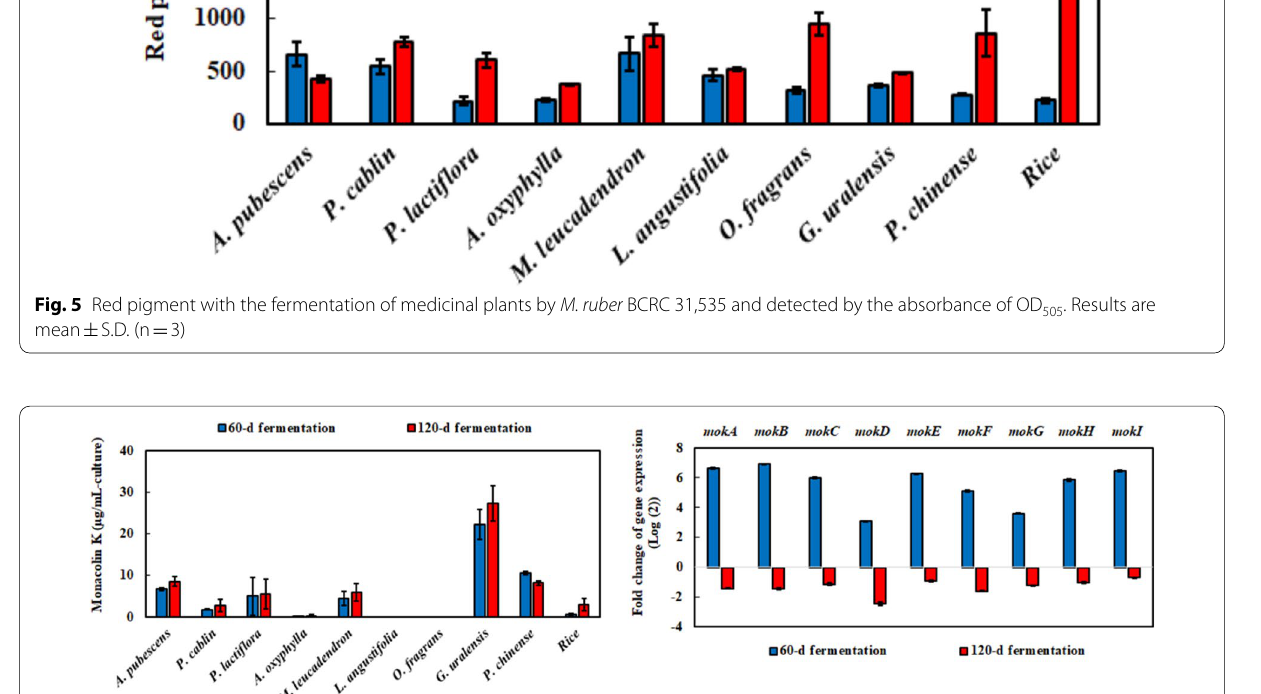
Fig. 6 Monacolin K with the fermentation of medicinal plants by M. ruber BCRC 31535 and its gene expression of M. ruber BCRC 31535‑fermented G. uralensis and rice by RT‑qPCR. The log(2) fold change of M. ruber BCRC 31,535‑fermented G. uralensis to M. ruber BCRC 31,535‑fermented rice by monacolin K gene expression was depicted on the right side of the figure. The 18 S rRNA was used as the positive control to normalize the data. Results are mean S.D. (n ± =